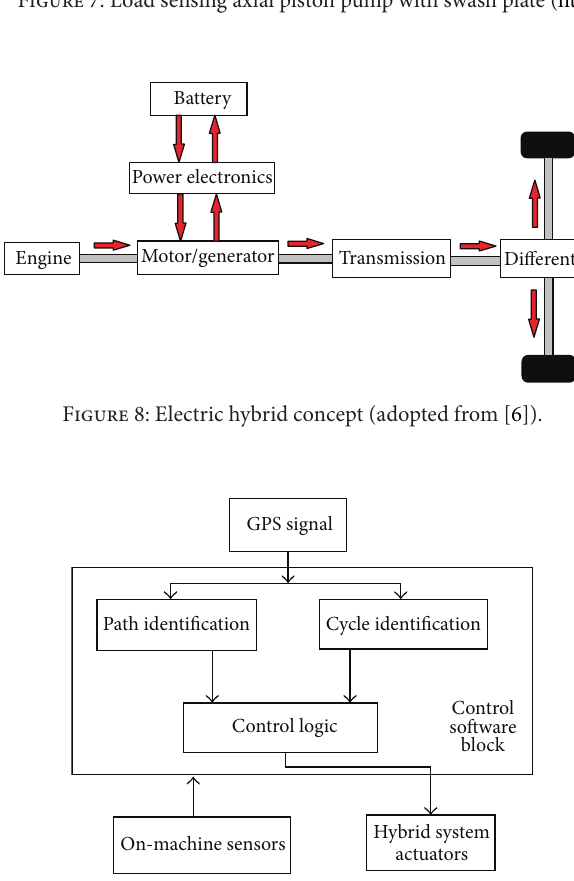
Figure 7: Load sensing axial piston pump with swash plate (http://www.mobilehydraulictips.com/efficient-mobile-hydraulic-systems/).